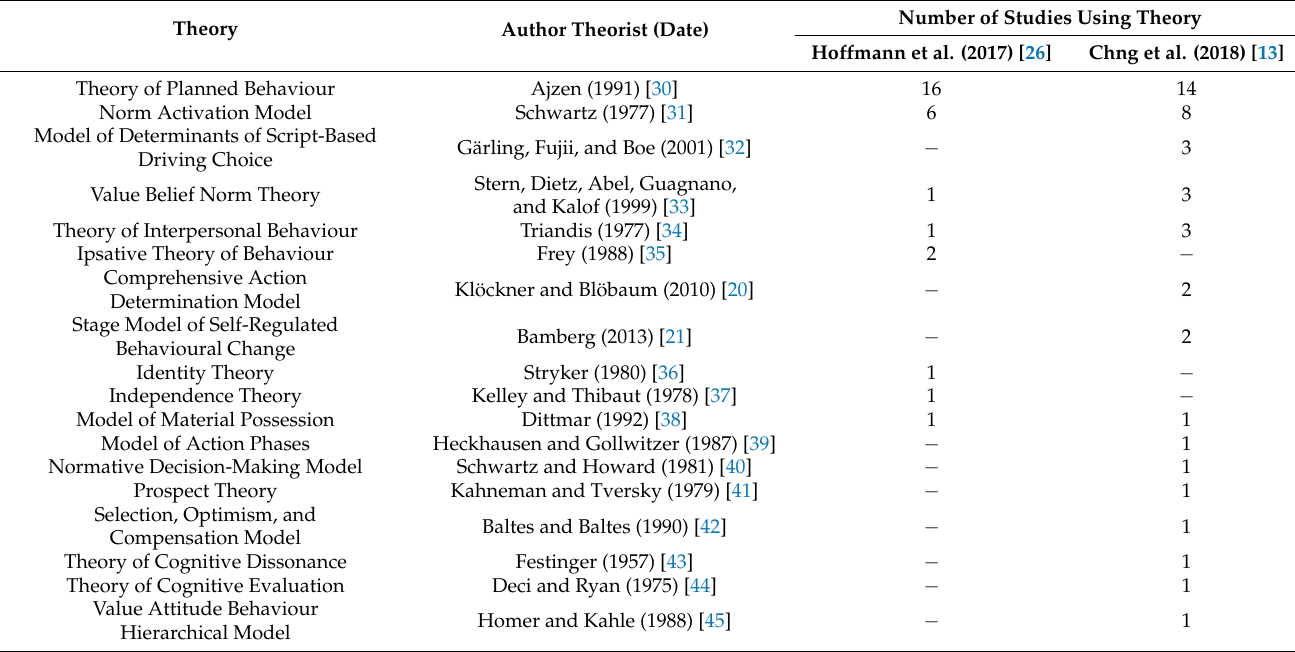
Table 1. Behaviour and behaviour-change theories in mobility research identified by Hoffmann et al. (2017) [26] and Chng et al. (2018)